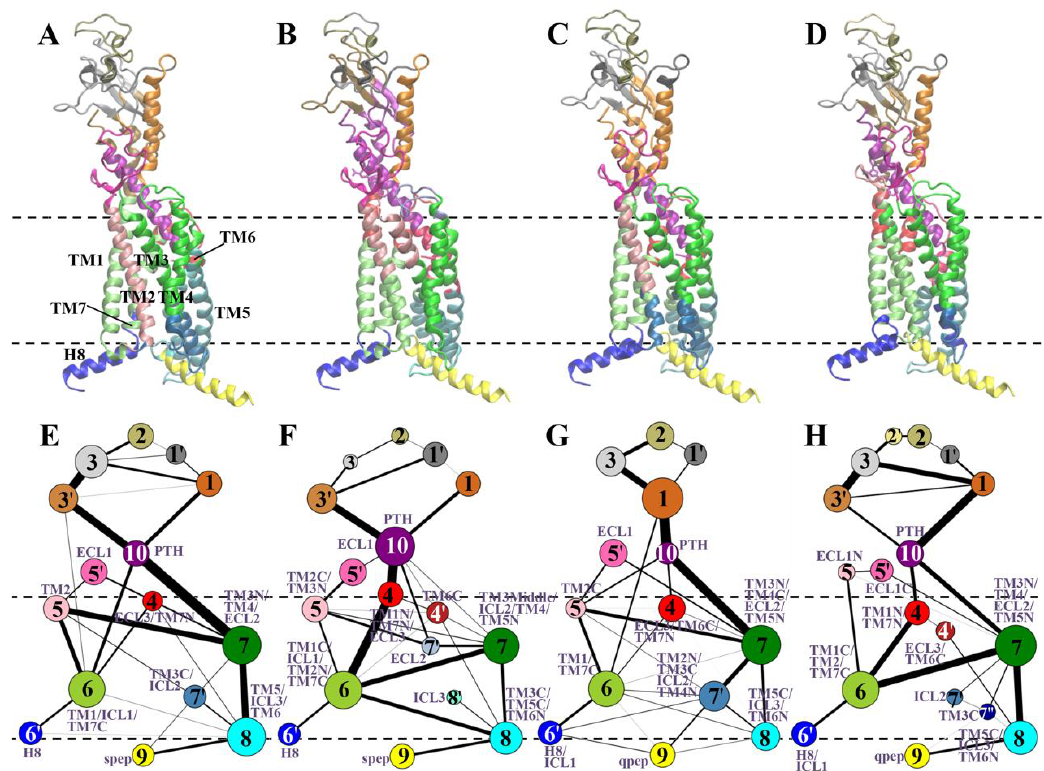
Figure 7. Community network for each system. Communities are highlighted as circles with different colors, which are consistent across all systems. The inter-community cumulative betweennesses are displayed by the thickness of lines connecting communities. ( A , E ) PTH1R – PTH – spep